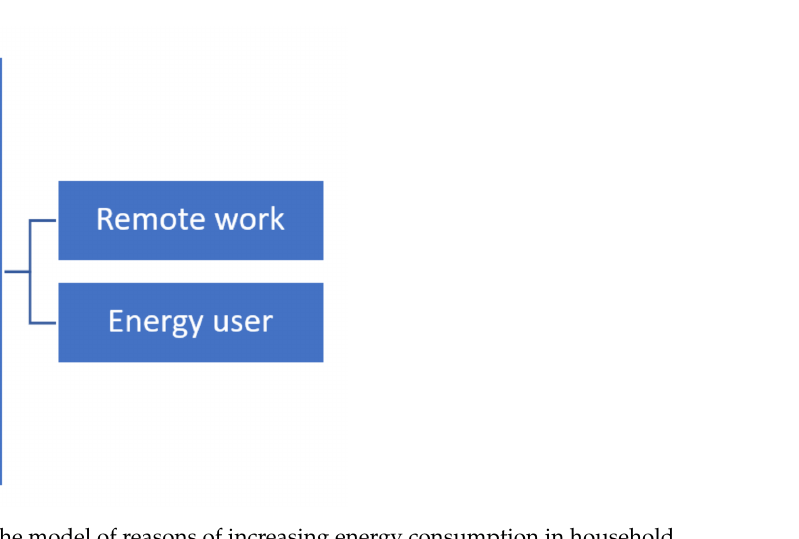
Figure 4. The model of reasons of increasing energy consumption in household.